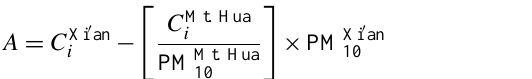
Figure 7. Relative abunance of component to PM10 from Xi’an and Mt. Hua during (a) the non-dust storm and (b) the dust storm periods